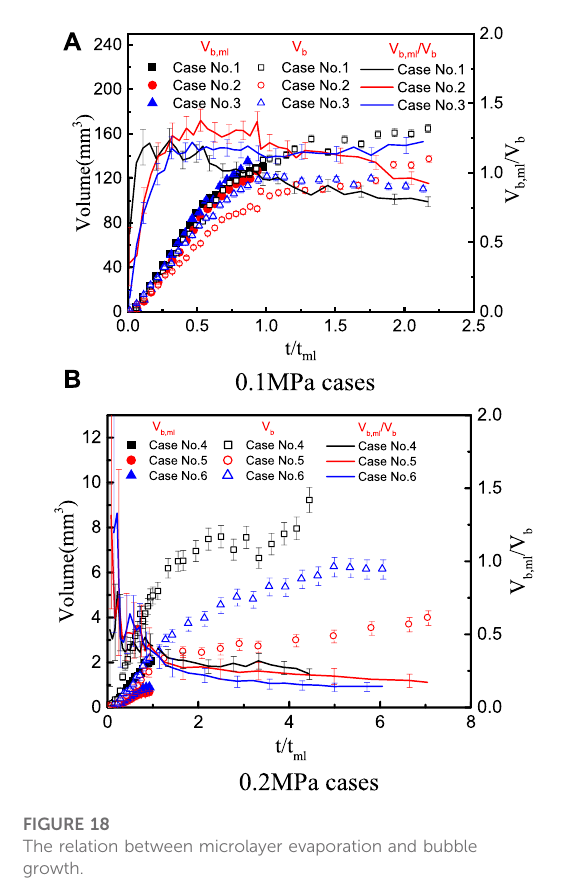
FIGURE 18 The relation between microlayer evaporation and bubble growth.